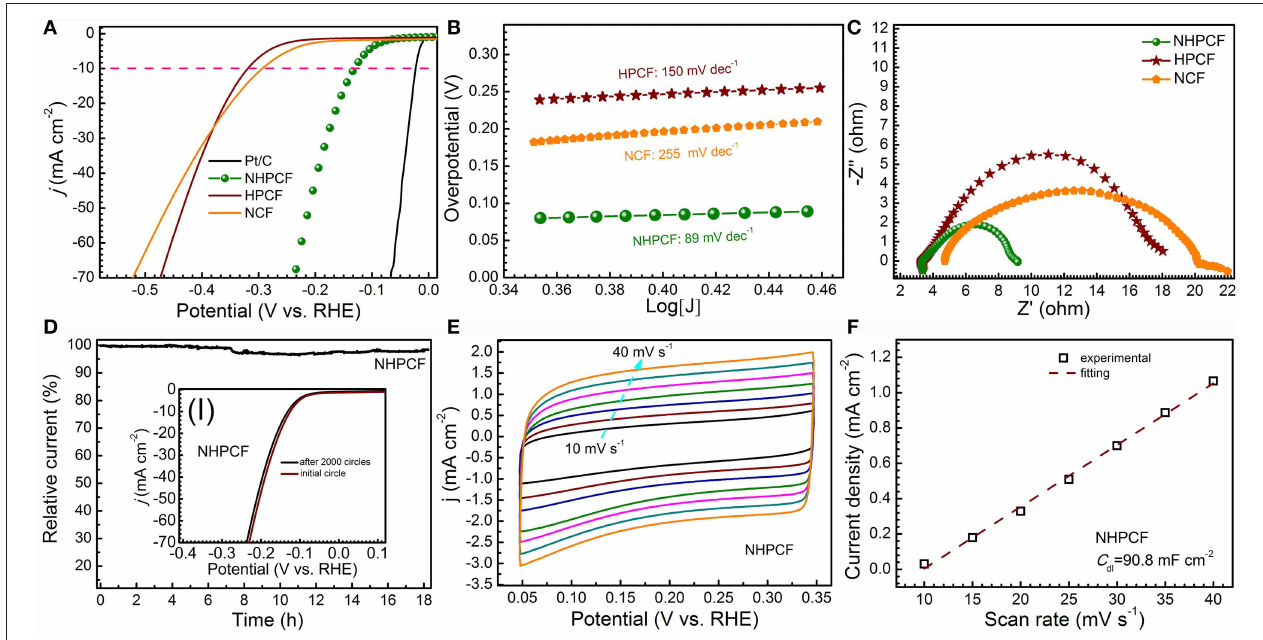
FIGURE 3 | (A) LSV curves for Pt/C (10%), NCF, HPCF, and NHPCF in 0.5M H 2 SO 4 solution with scan rate of 5 mV · s − 1 , (B) Tafel plots (C) Nyquist plots of NCF, HPCF, and NHPCF, (D) current–time plot at − 0.15V (vs. RHE) (inset shows initial polarization curves for NHPCF and that after 2,000 cycles of potential sweeps), (E) CV curves of NHPCF at different scan rates, and (F) corresponding evaluation of the C dl for NHPCF.